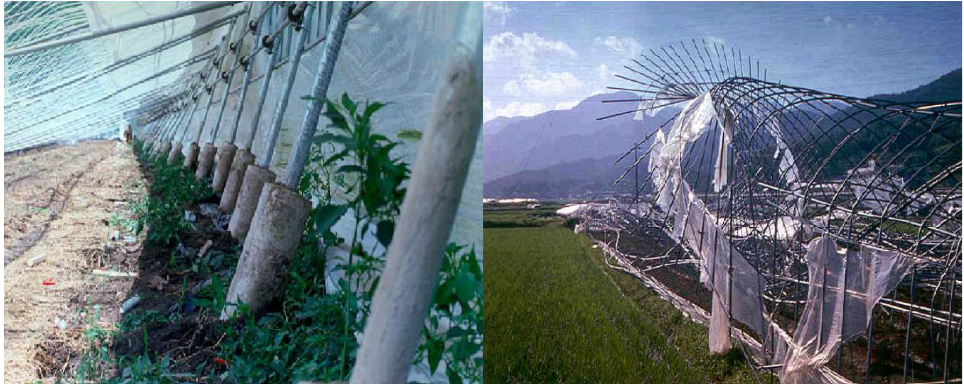
Figure 1. Case of foundation damage of single-span plastic greenhouse [28].